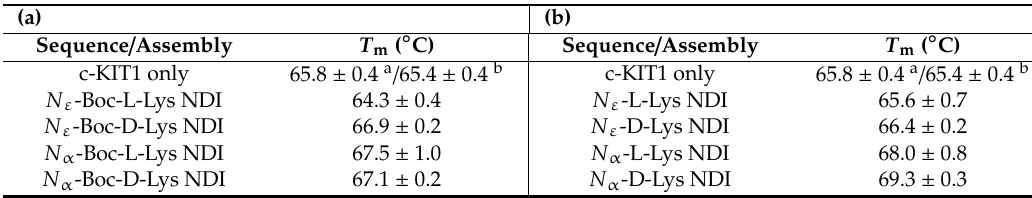
Table 2. The T m values of c-KIT1 only compared to the T m of ( a ) c-KIT1-Boc-protected-NDIs and ( b ) c-KIT1-deprotected-NDIs as determined from VT CD studies.